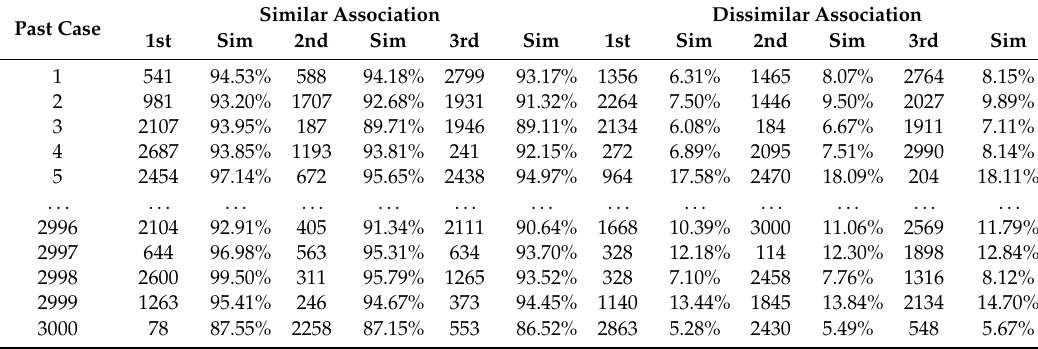
Table 6. Part of the generated association